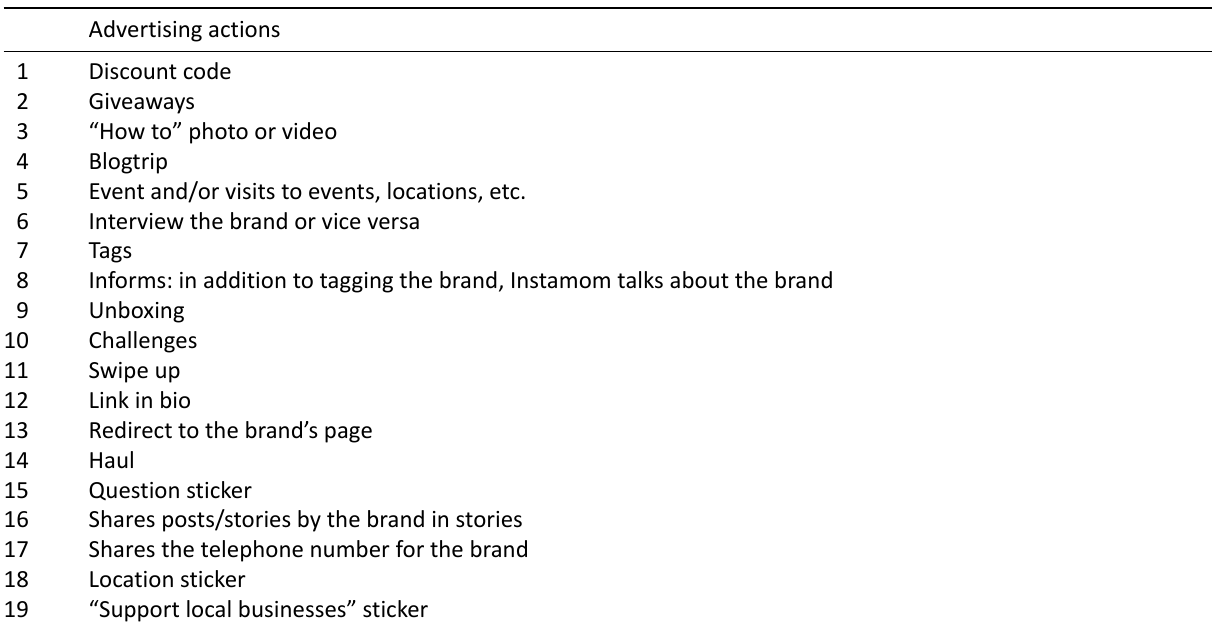
Table 2. Advertising actions by Instamoms.